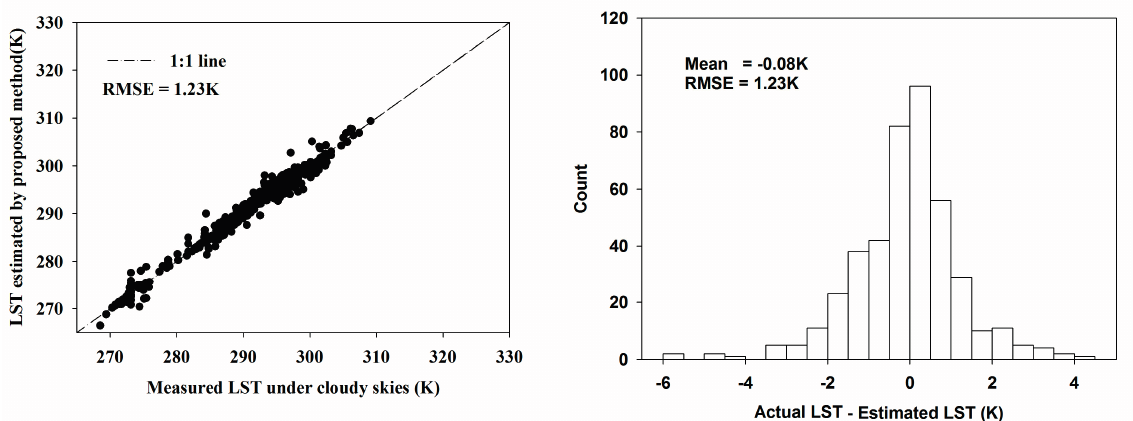
Figure 5. Comparison of the measured daytime LST and the daytime LST predicted by the proposed method under cloudy skies at the Chang Wu Ecosystem experimental station in 2012 ( left : scatter plot; right : histogram of errors of the measured and estimated